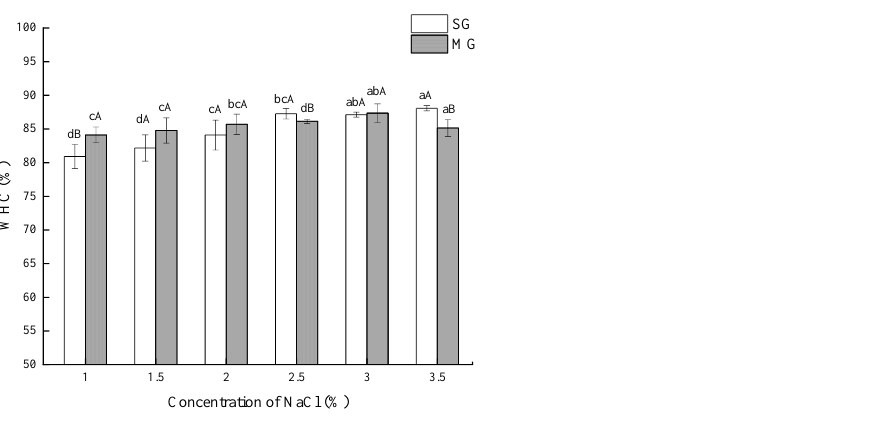
Figure 2. Effects of different NaCl concentrations on WHC of SG and MG. Different lowercase letters show significant differences between the groups with different NaCl concentrations ( p < 0.05). Different capital letters show significant differences ( p < 0.05) between SG and MG.